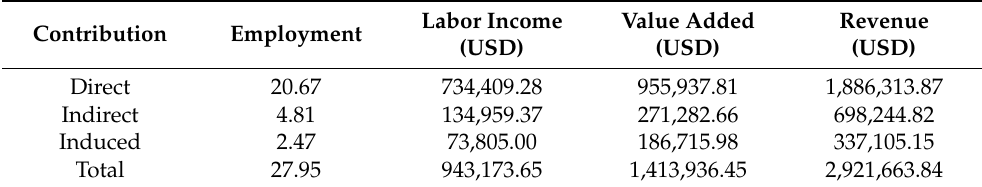
Table A21. Contribution of Apalachicola Spending to Franklin County (Annual).